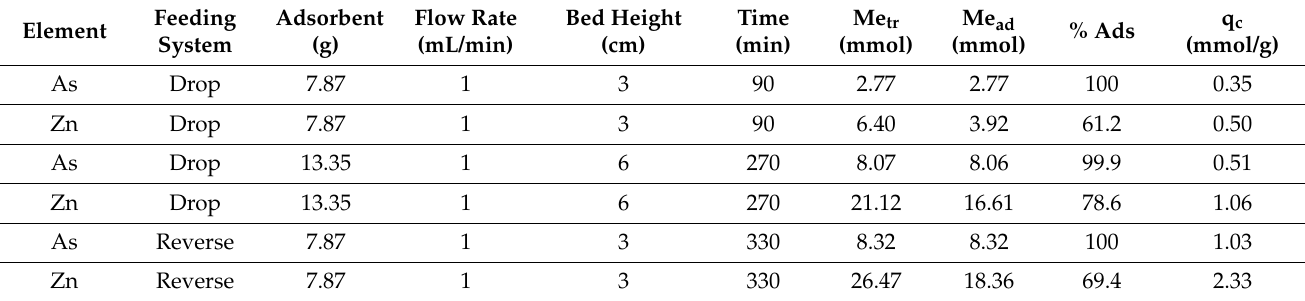
Table 4. Arsenic and zinc adsorption in columns charged with encapsulated biogenic iron under different experimental conditions. Flow Rate Feeding Adsorbent (g) Element (mL/min) System